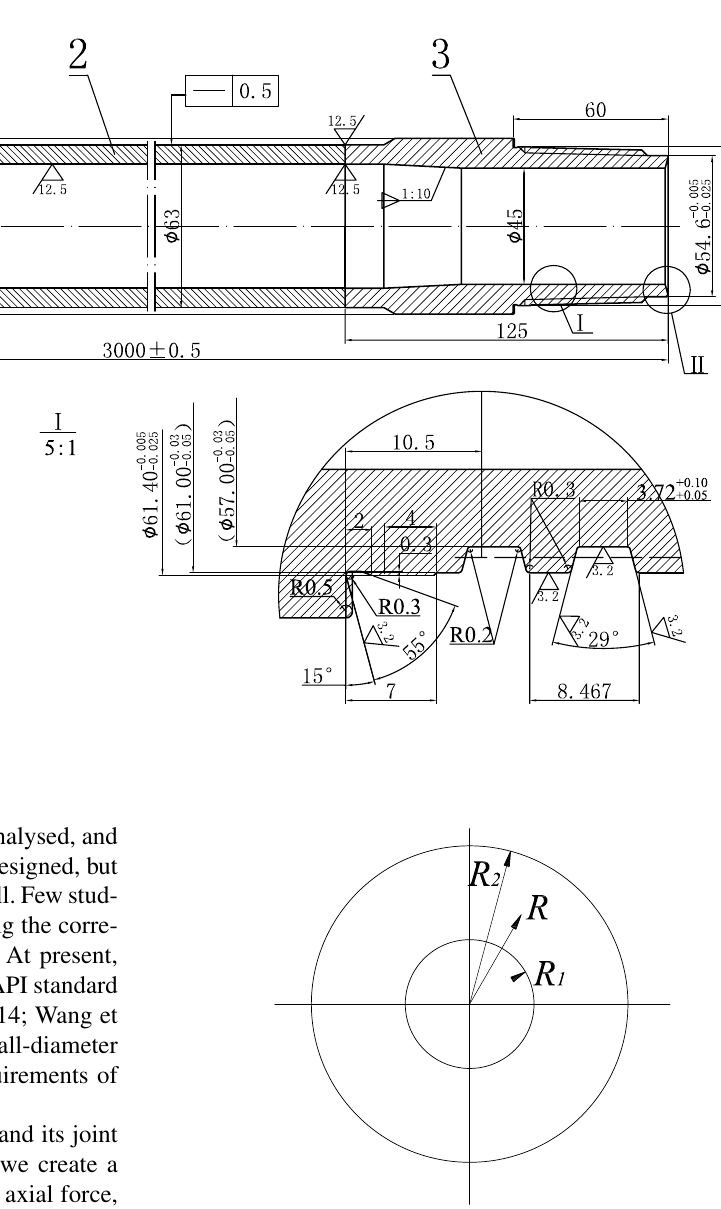
Figure 2. Basic model of the joint for stress